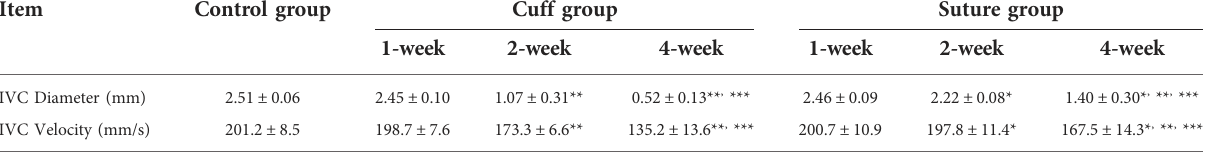
*Indicates P <0.05 compared with rats in cuff group. **Indicates P <0.05 compared with rats in 1-week group. ***Indicates P <0.05 compared with rats in 2-week